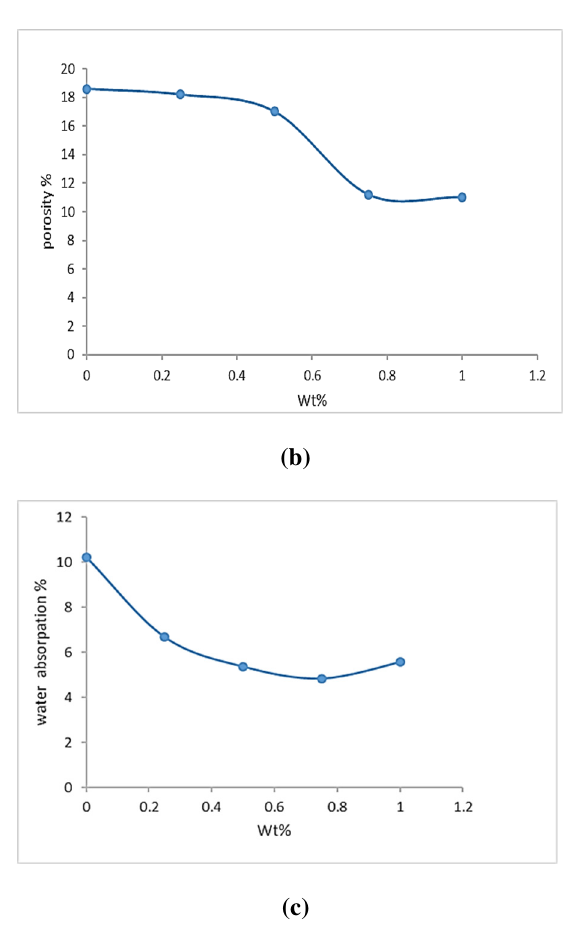
Fig. 2. The physical properties of cement mortar .